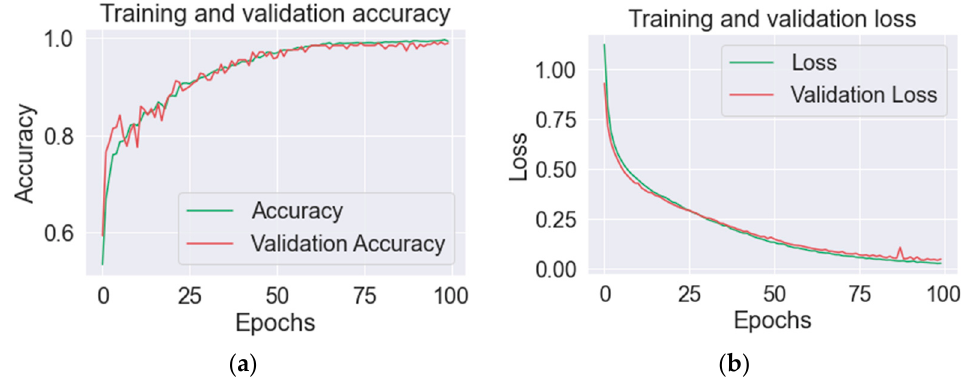
Figure 7. Proposed model results in ( a ) training and validation precision, and ( b ) loss of training and validation.